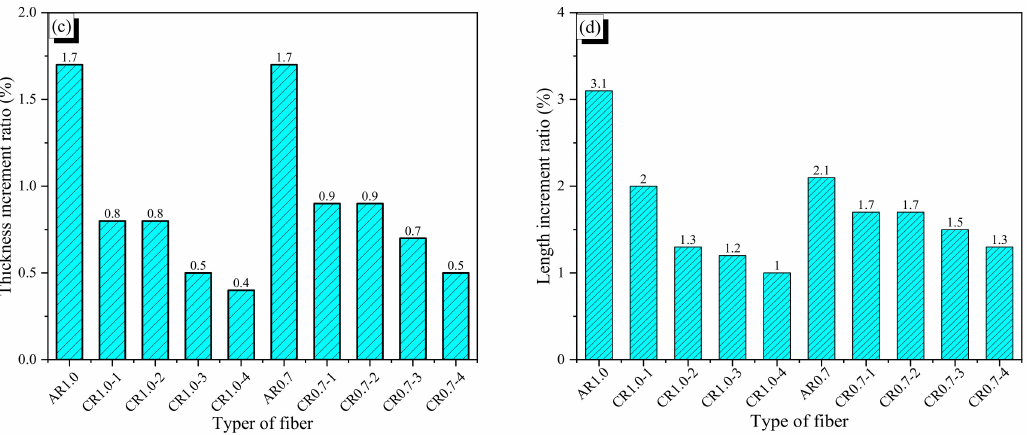
Figure 4. Dimension ratios of fibers: ( a ) wave depth ratio; ( b ) decrement of wave depth; ( c ) thickness increment ratio; and ( d ) length decrement ratio.